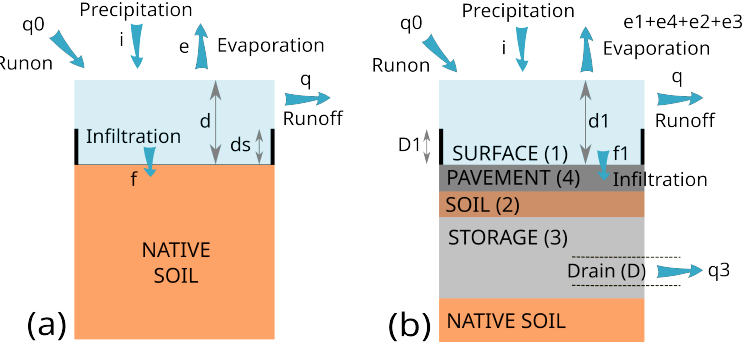
Figure 2. Non-linear reservoir models for ( a ) a pervious area and ( b ) an LID